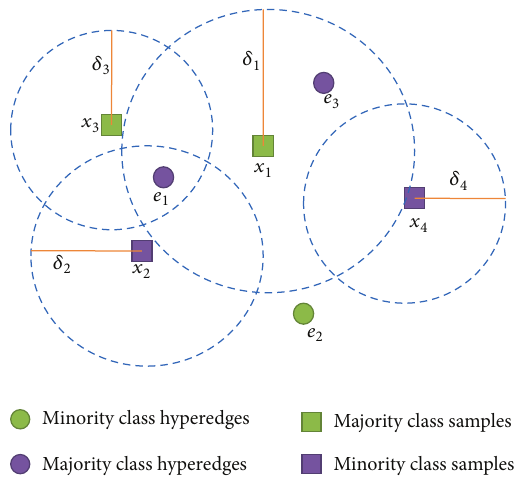
Figure 7: Hyperedges whose confidence degree is under 𝜆 .